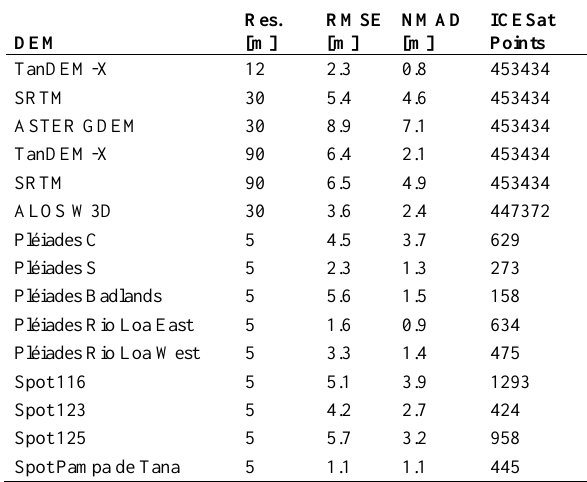
Table 1. Overall accuracies of all digital elevation